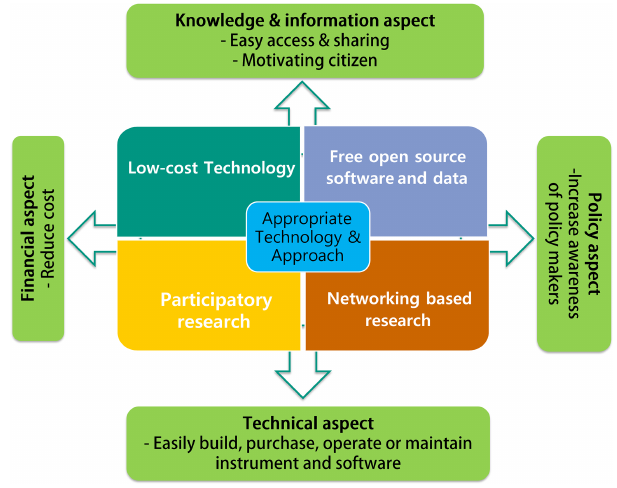
Figure 5. Major components of appropriate technology and ap- proach (AT&A) and its benefits for enhancing carbon and green- house gas research in developing countries.